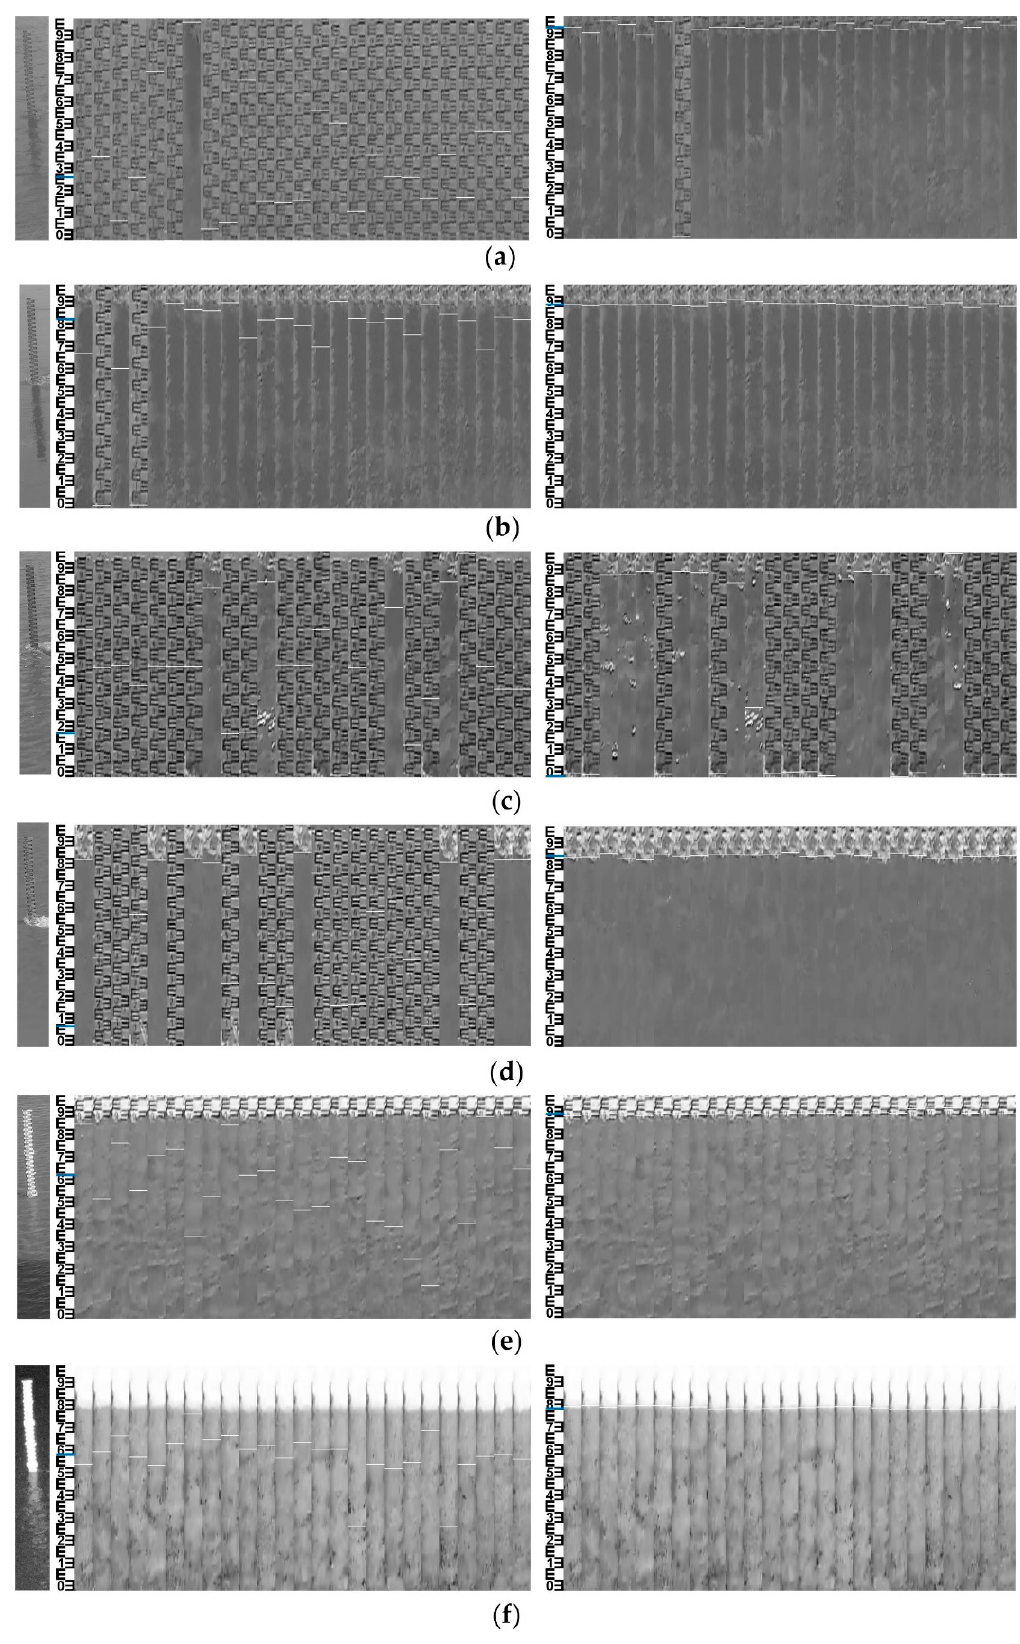
Figure 12. The original water gauge images (left) and visualized OSF (middle) and MMD (right) measurements: ( a ) 6:30:00 dim light; ( b ) 8:10:00 shadow projection; ( c ) 9:50:00 water glare; ( d ) 14:10:00 direct sunlight; ( e ) 17:00 lateral sunlight; ( f ) 19:20:00 artificial lighting.